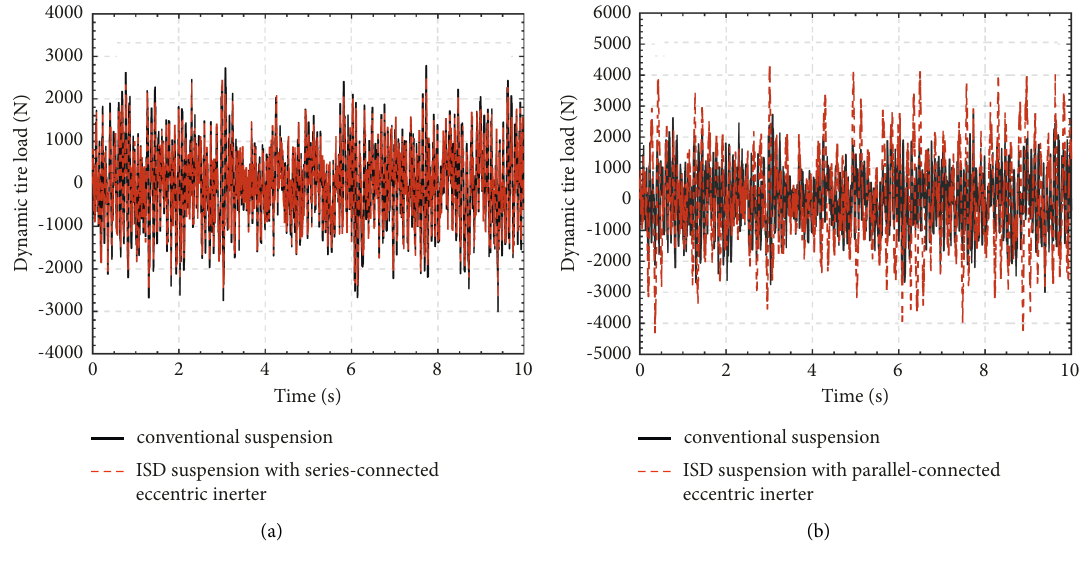
Figure 6: Responses of dynamic tire load in time Table 4: Dynamic performance indices.